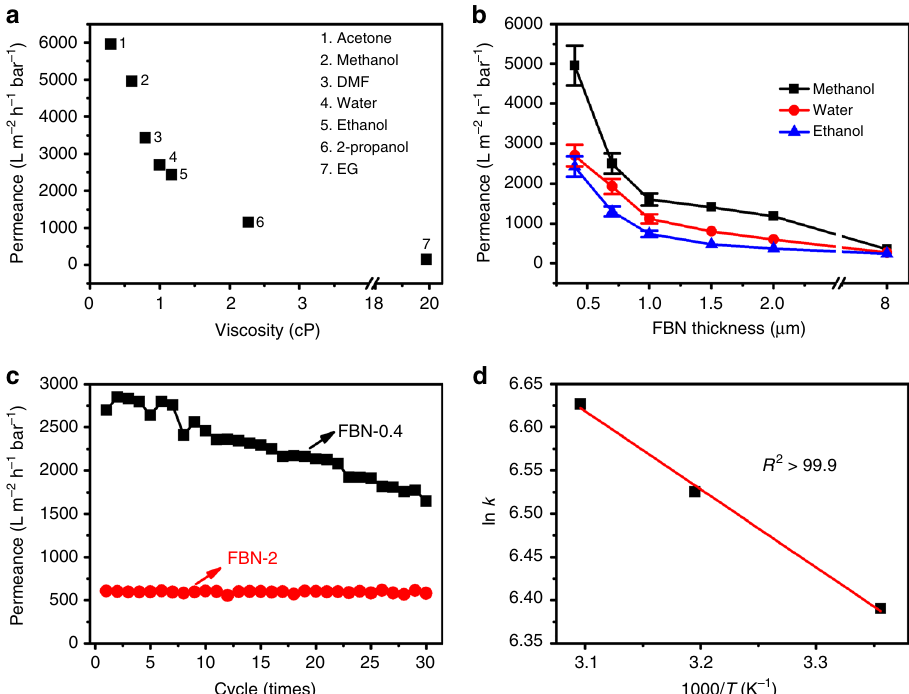
Fig. 3 Pure solvent permeance of the functionalized boron nitride membranes. a The plot of the solvent fi ltration ability versus the viscosity of different solvents (EG is ethylene glycol) through FBN-0.4, and b the effect of the membrane thickness on the fi ltration. c The water permeation performance of the FBN-0.4 and FBN-2 membranes with 30 periodic operations of water fi ltration, and d the Arrhenius plot of the water permeation rate (ln k ) versus inverse temperature (1000/T) for nm 45 . Most FBN fl akes contain 2 – 4 layered BN fl akes with a size area of 0.01 – 0.06 μ m 2 . Thus, the small lateral FBN lamina creates more nanochannels for molecules to pass through.